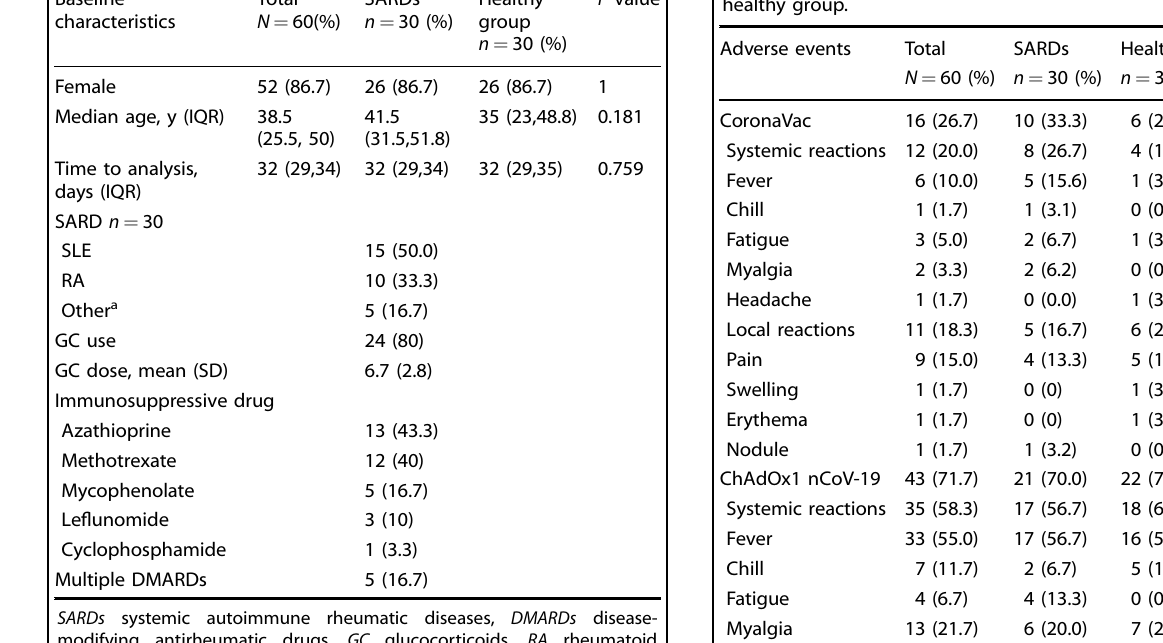
Table 2. Adverse events following immunization with CoronaVac followed by ChAdOx1 nCoV-19 (Oxford-AstraZeneca) in the systemic autoimmune rheumatic diseases (SARDs) group and the healthy